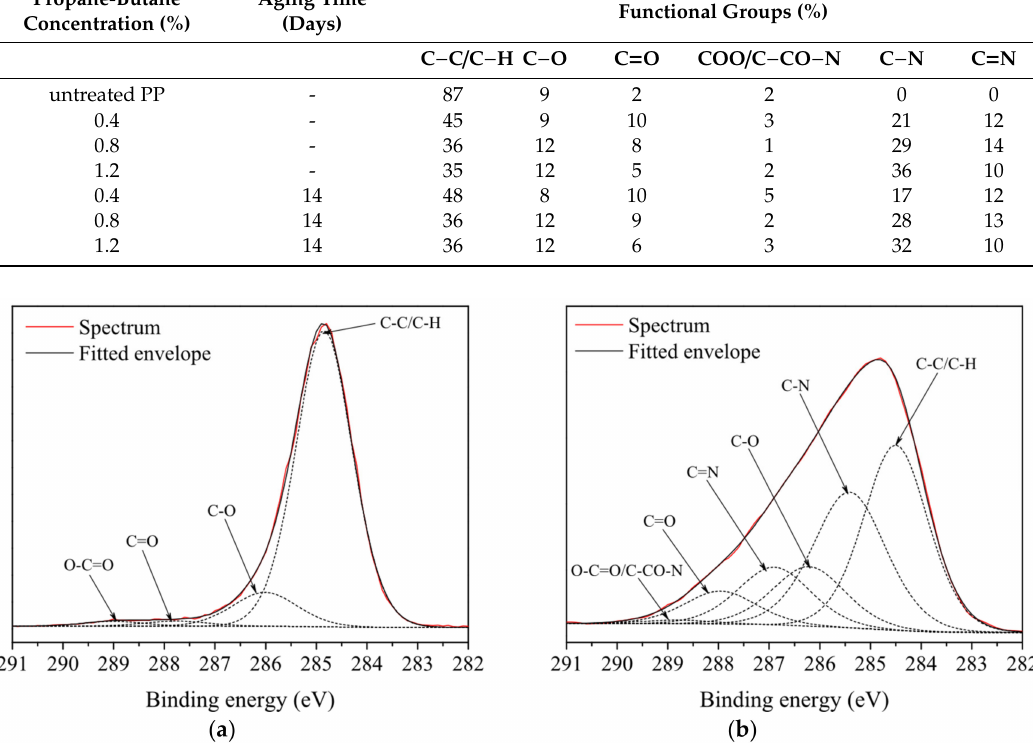
Figure 7. C1s high resolution scan of: ( a ) untreated sample; and ( b ) sample treated for 10 seconds in processing gas with volume concentration of precursor of